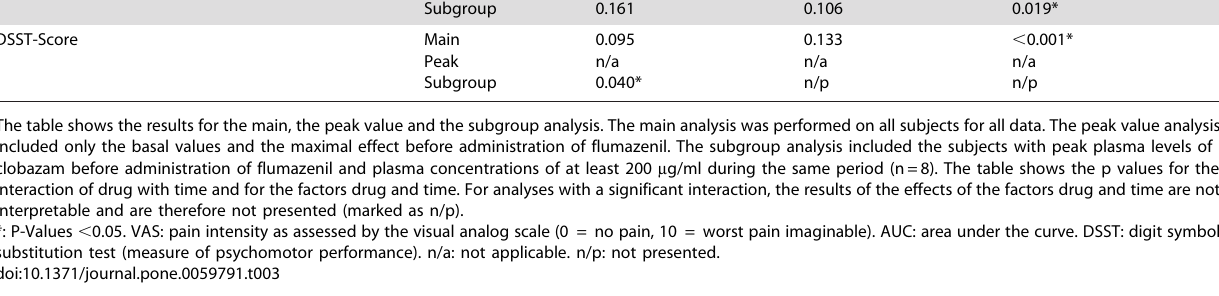
Peak value and subgroup analyses. The peak value analysis did not yield statistically significant results. In the subgroup analysis, there was again a significant interaction between time and drug (p = 0.017). Pairwise multiple comparisons within each drug showed that clonazepam significantly decreases the area of hyperalgesia between the time-point 60 min and the measurement after flumazenil (p =0.004), indicating that fluma- zenil could not abolish the clonazepam effect.